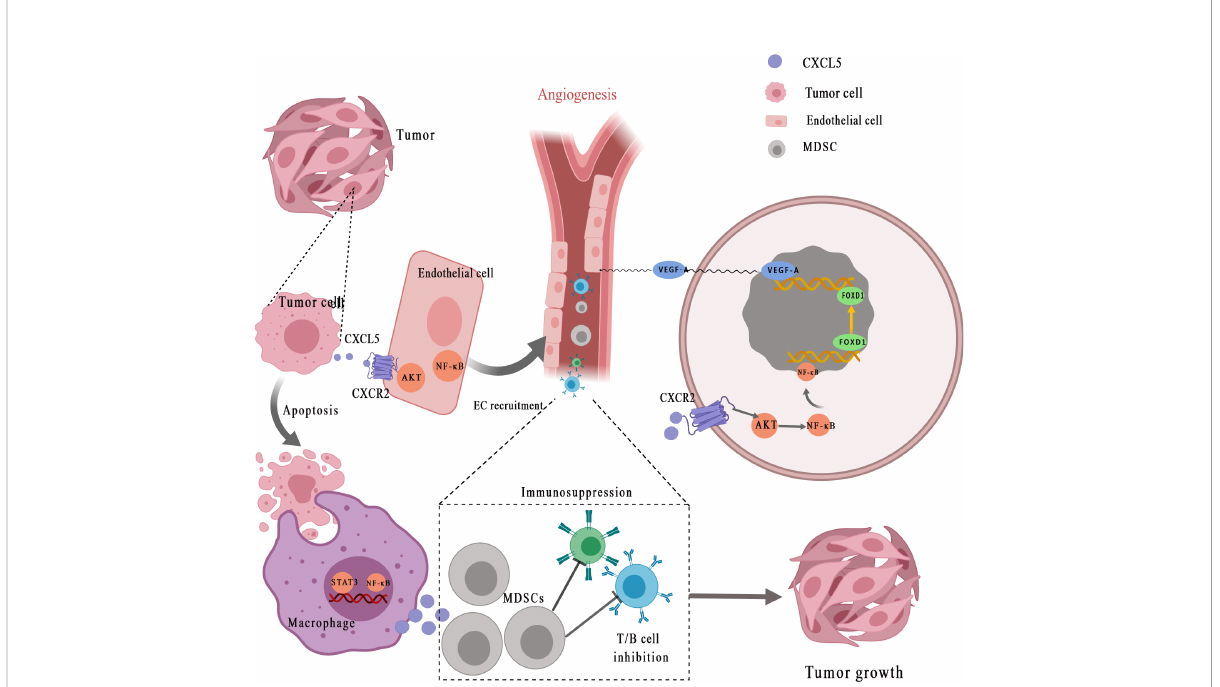
FIGURE 2 CXCL5 promotes the recruitment of vascular endothelial cells for angiogenesis and helps form the tumor-promoting microenvironment. Tumor cells secret CXCL5 for interaction with its receptor CXCR2, which subsequently activates NF- k B and AKT signaling transduction in endothelial cells. CXCL5 facilitates the recruitment and activation of in fl ammatory myeloid-derived suppressor cells (MDSCs), eventually leading to persistent in fl ammation and immunosuppression, thereby stimulating tumor progression. MDSCs, myeloid-derived suppressor cells; EC, endothelial cell; STAT3, signal transducer and activator of transcription 3; NF- k B, nuclear factor ‐ k appa B; VEGF-A, vascular endothelial growth factor-A; FOXD1, Forkhead Box